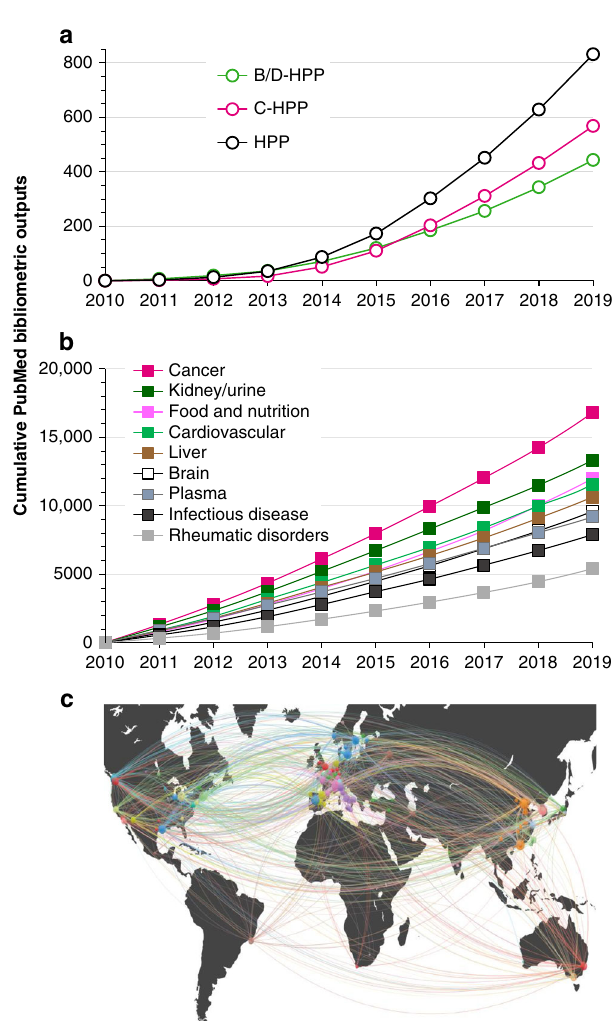
Fig. 5 Assembly of the Human Proteome Reference Library (HPRL).